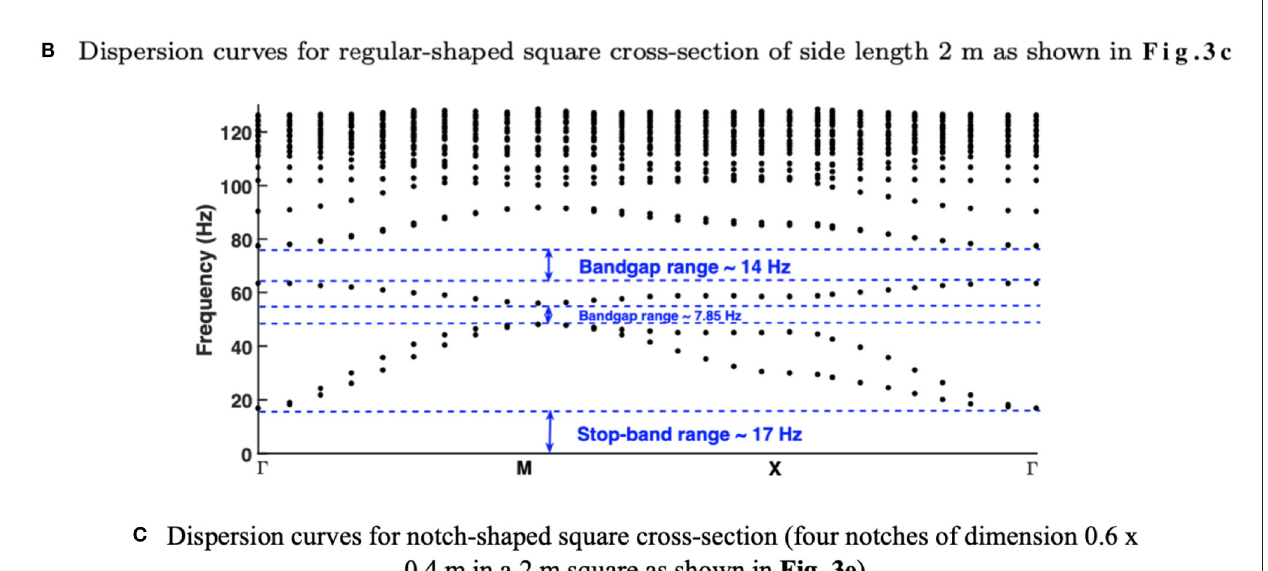
FIGURE 4 | Dispersion curves for clamped configuration of geometries, i.e., the base of the inclusion column is clamped, shown in Figure 3 with the same substitution ratio 0.445. Notch-shaped square cross-section shows a higher stopband than the other two geometries, however, the frequencies are lifted up in their comparison. (A) Dispersion curves for circular cross-section with 1.128 m radius as shown in Figure 3A . (B) Dispersion curves for regular-shaped square cross-section of side length 2 m as shown in Figure 3C . (C) Dispersion curves for notch-shaped square cross-section (four notches of dimension 0.6 × 0.4 m in a 2 m square as shown in Figure 3E